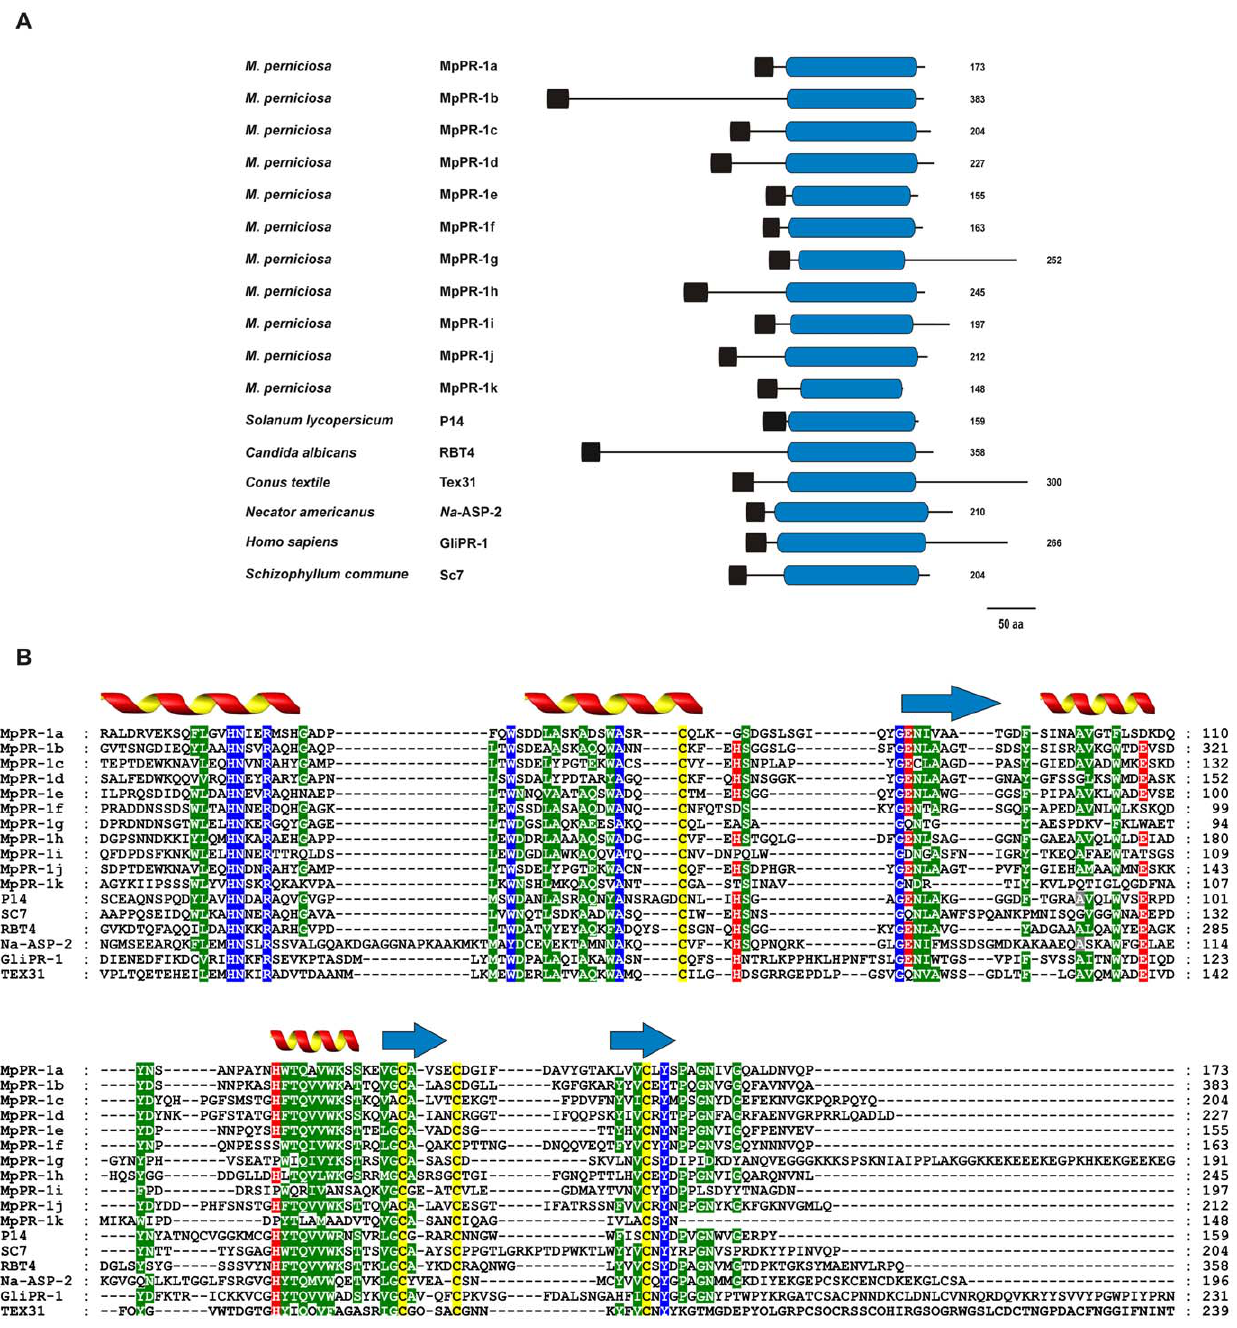
Figure 1. Comparison of MpPR-1 and SCP/TAPS proteins of representative organisms. (A) Domain arrangement of SCP/TAPS proteins. Hydrophobic signal peptides are shown in black and SCP/TAPS domains are represented in blue. The numbers on the right show the size of each protein. Large N-terminal and C-terminal expansions are observed in MpPR-1b and MpPR-1g, respectively. (B) Alignment of the conserved domain of SCP/TAPS proteins. In general, the SCP/TAPS superfamily members show similarities only over the SCP/TAPS domain. Conserved residues (100% of identity) are shown in blue and semi-conserved residues (at least 60% of identity) in green. Putative active site residues are highlighted in red and cysteines in yellow. Secondary structure elements are shown above the alignment (arrow: b -sheets; helix: a -helixes). P14, tomato PR-1 (GenBank P04284); RBT4, repressed by TUP1 from Candida albicans (GenBank AAG09789); Tex31, SCP/TAPS from the mollusk Conus textile (GenBank CAD36507); Na-ASP-2, Necator americanus secreted protein (GenBank AAP41952); GliPR-1, human glioma PR-1 protein (GenBank P48060); SC7, SCP/TAPS from the basidiomycete Schizophyllum commune (GenBank P35794).